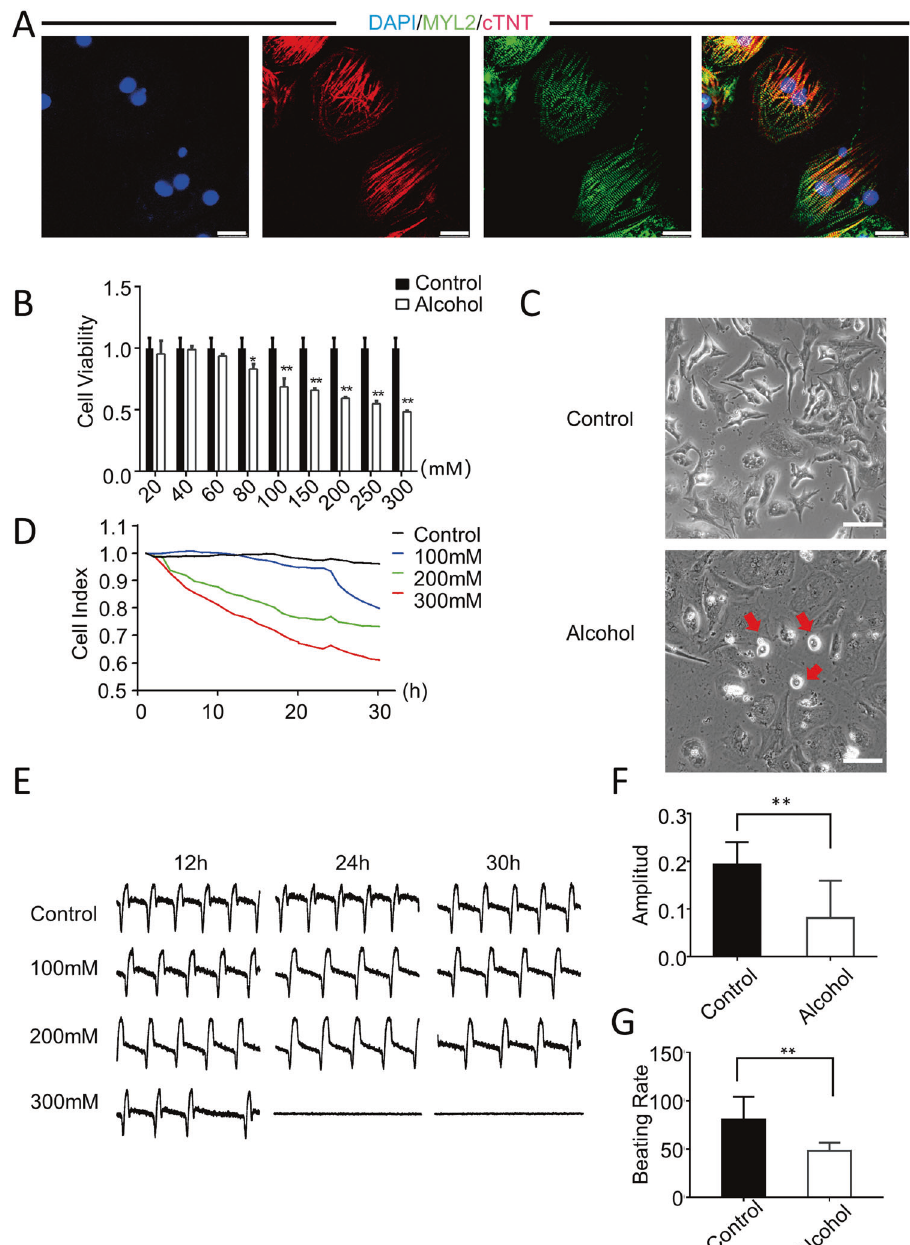
Fig. 1 Modeling alcoholic cardiomyopathy using hiPSC-CMs. A Representative immunostaining for the expression of MYL2 (green) and cTNT (red) in hiPSC-CMs. Scale bar = 50 μ m. B CCK-8 assay showed that the cell viability decreased to 95.3, 98.9, 93.6, 83.1, 68.5, 59.4, 54.8, and 48.3% after treatment with different concentrations of alcohol (i.e., 20, 40, 60, 80, 100, 150, 200, 250, and 300 mM) for 24 h ( n = 4). C Representative images showed that hiPSC-CMs shrink and became round after alcohol treatment. Scale bar = 200 μ m. D RTCA was used to monitor the changes in cell index after treating hiPSC-CMs with different concentrations of alcohol (i.e., 100, 200, and 300 mM) for 30 h ( n = 30). E – G Changes in vibration amplitude and beat frequency over a 30-h period [ F ( n = 39); G ( n = 41)]. Results are presented as means ± standard error of the mean (* P < 0.05, ** P < 0.01, *** P < 0.001; two-sided Student ’ s t -test or one-way analysis of variance).